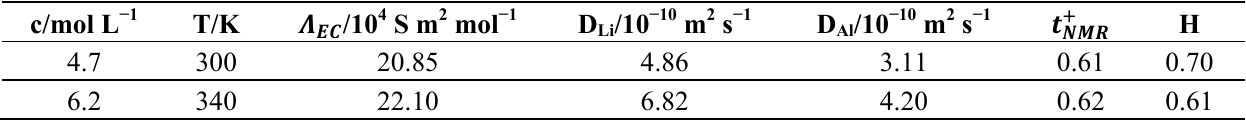
Table 2. Results of the conductivity measurements and DOSY-NMR